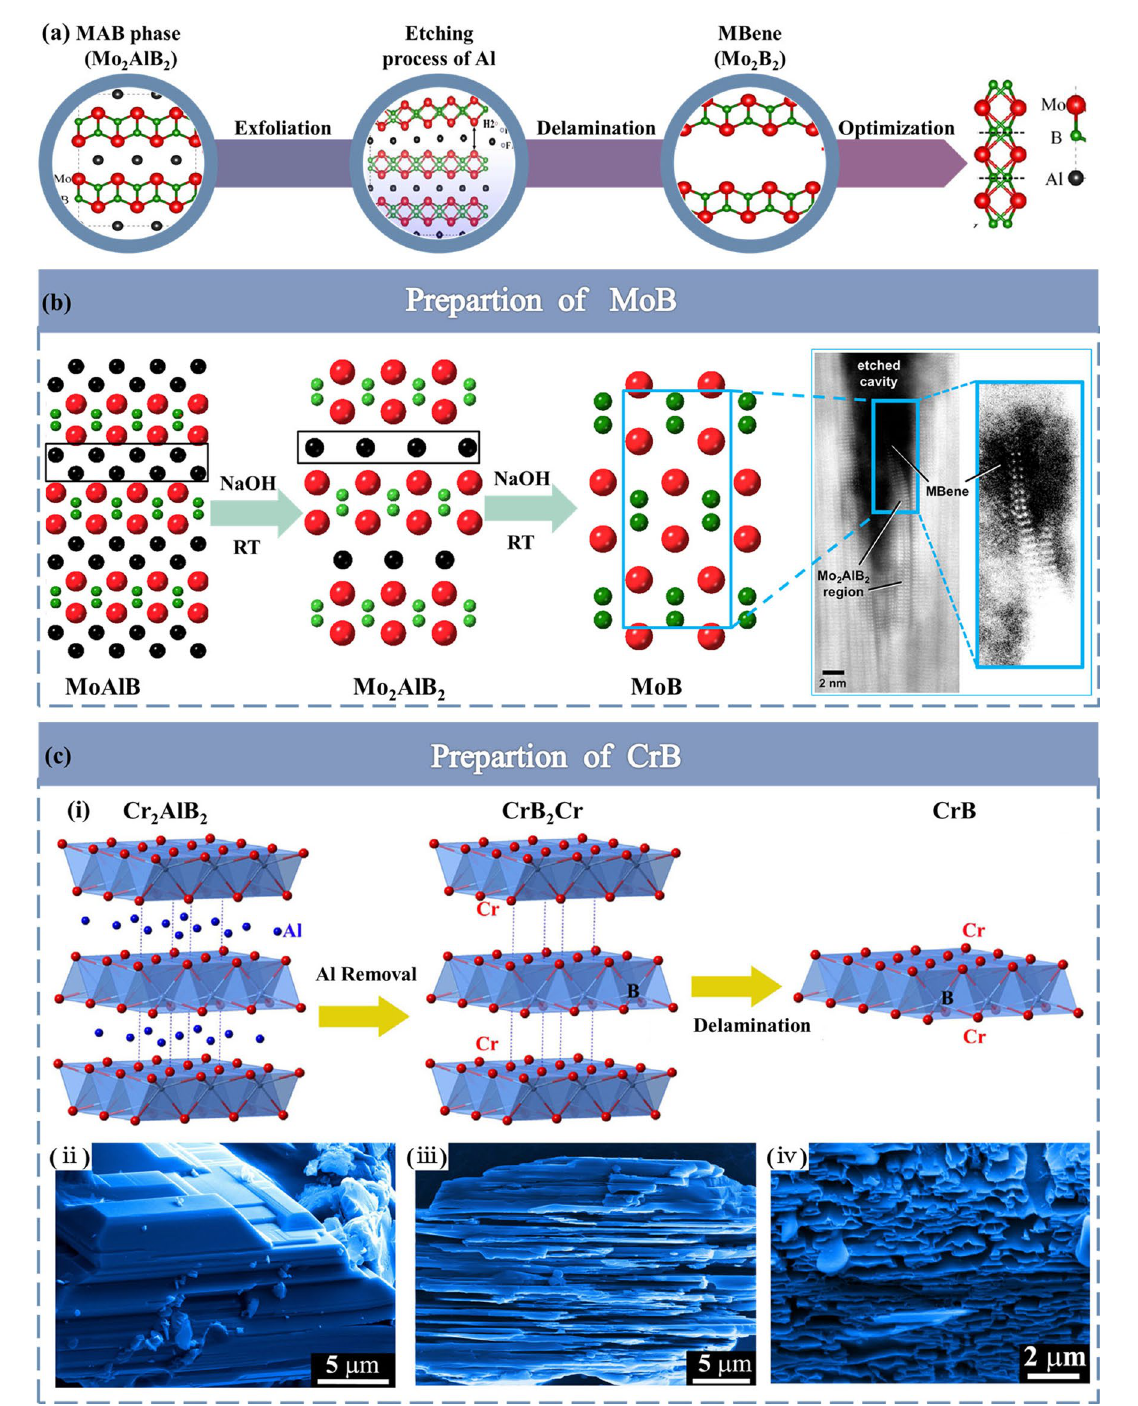
Fig. 4 a Schematic describing the synthesis, delamination and dispersion of Mo 2 B 2 based on theory. Reproduced with permission from Ref. [86]. b Synthesis routes for the preparation of MoB. ADF-STEM image of two isolated, delaminated MoB (MBene) sheets inside an etched cav- ity MoAlB at various stages of etching with 10% NaOH at room temperature. Reproduced with permission from Ref. [87]. c Synthesis routes for the preparation of CrB. ( i ) A simple 2D model of CrB 2 Cr built by removing the Al sheets from Cr 2 AlB 2 and separating the adjacent CrB 2 Cr units from a vacuum region of about 10 Å. Microstructure of Cr 2 AlB 2 powders before ( ii ) and after ( iii ) treatment in diluted HCl solution. ( iv ) 2D CrB nanosheets prepared by etching for 8 h in dilute HCl (1.25 mol L -1 ) solution. Reproduced with permission from Ref.